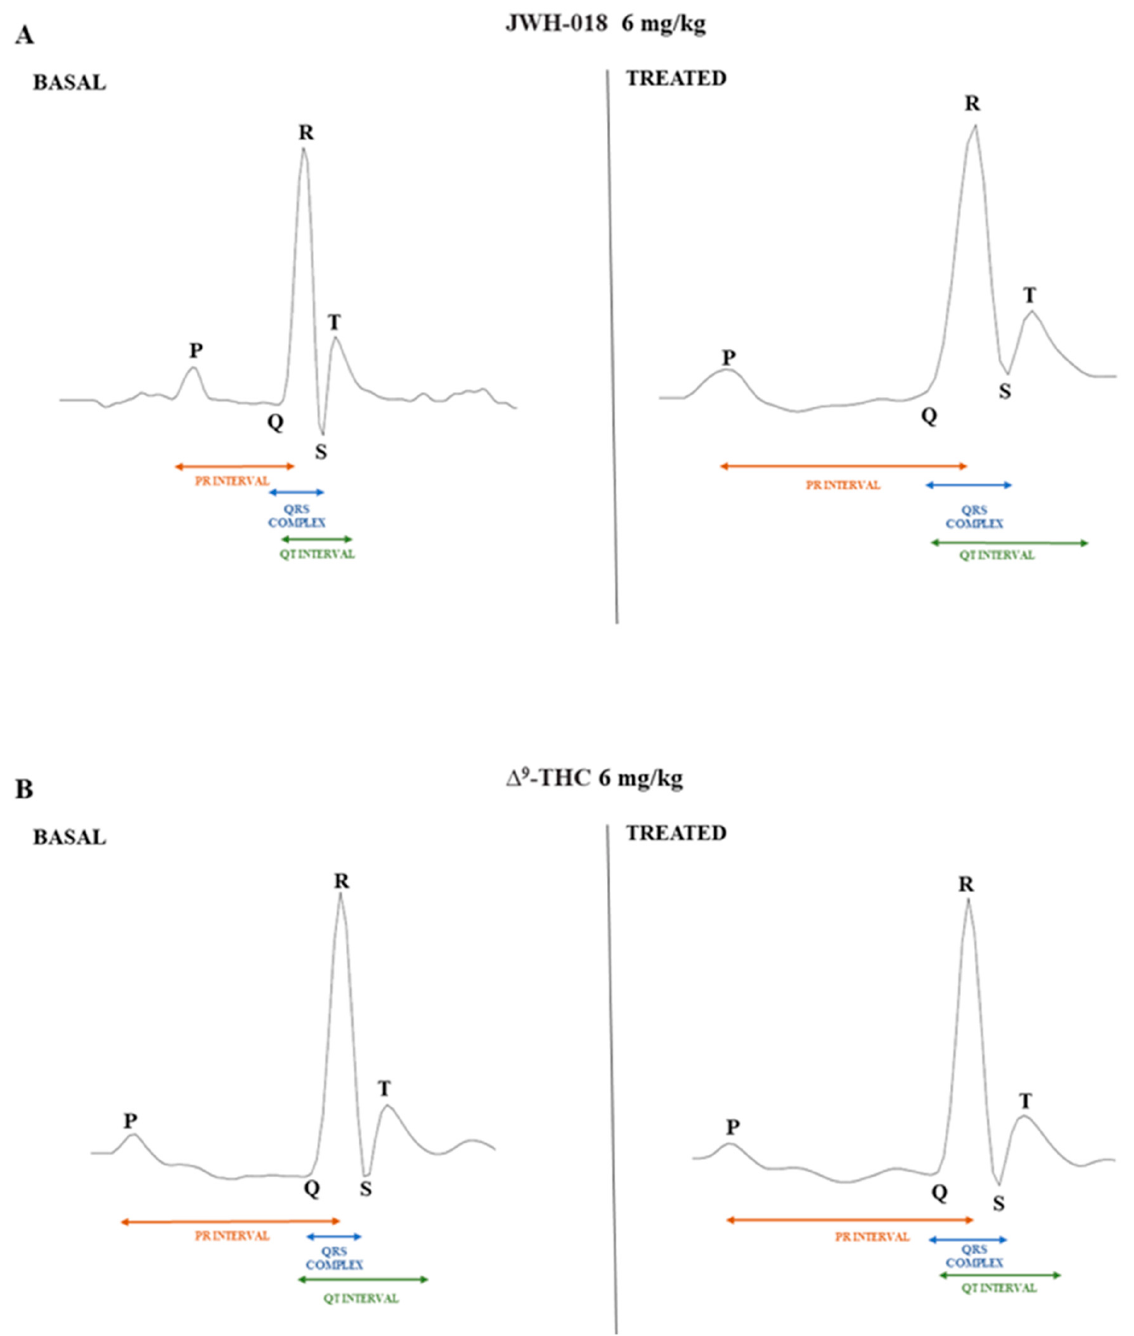
Figure 6. ECG waves after vehicle and JWH-018 (6 mg/kg) treatment (panel ( A )) and ECG waves after vehicle and ∆ 9 -THC (6 mg/kg) treatment (panel ( B )). Waves were recorded with ecgTUNNEL system (Emka Technologies) and exported after analysis with iox2 software.